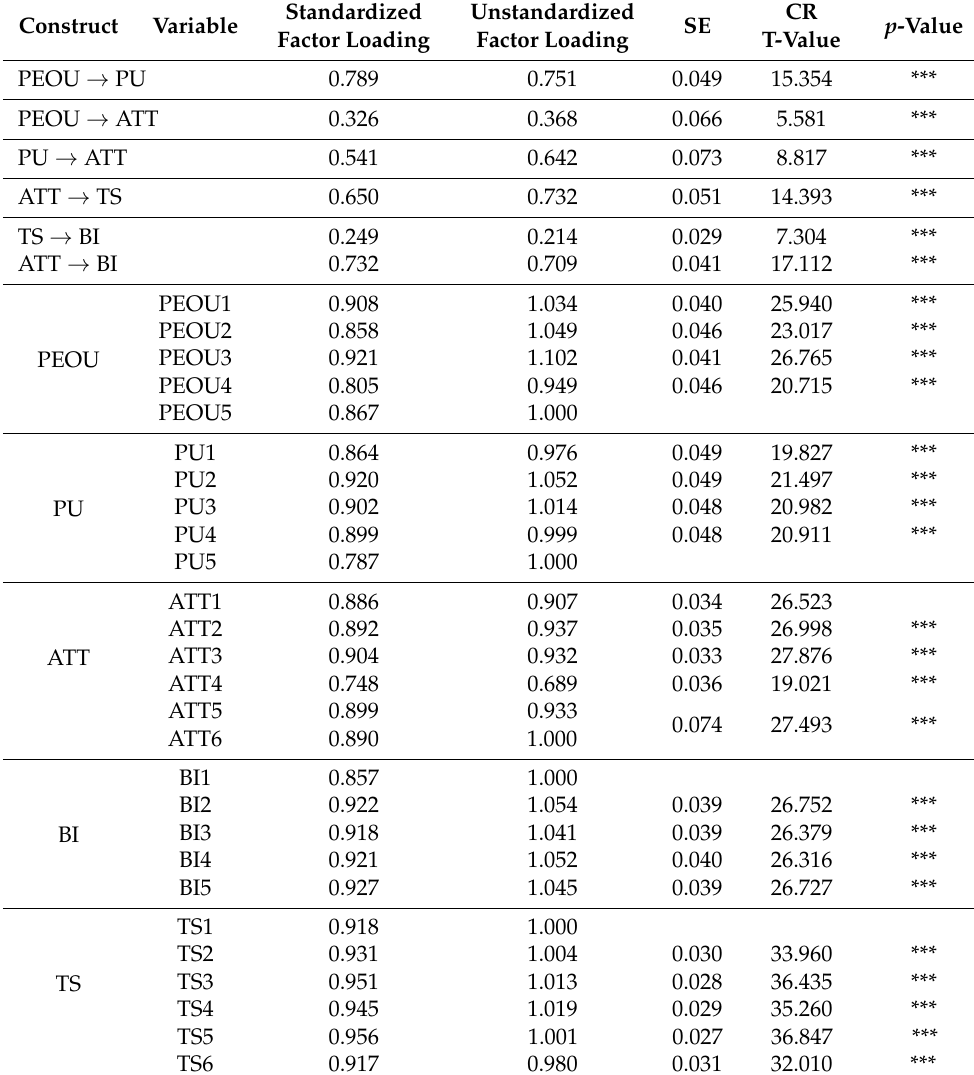
Table 10. Discriminant validity between